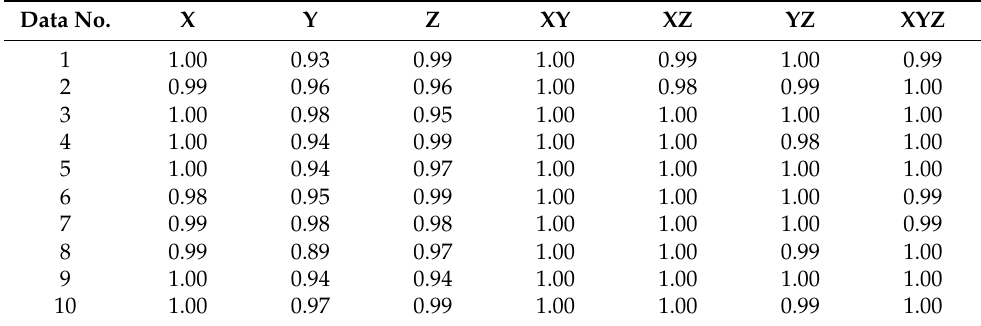
Table 9. CNN summary of ‘accuracy on test data’.